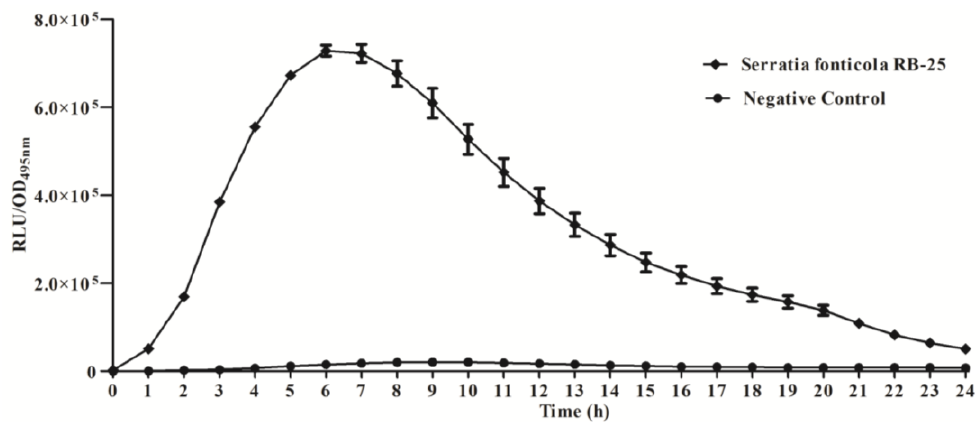
Figure 2. Detection of short chain AHLs produced by isolate RB-25 via E. coli [pSB401] biosensor. Three independent experiments were conducted and each point is the mean